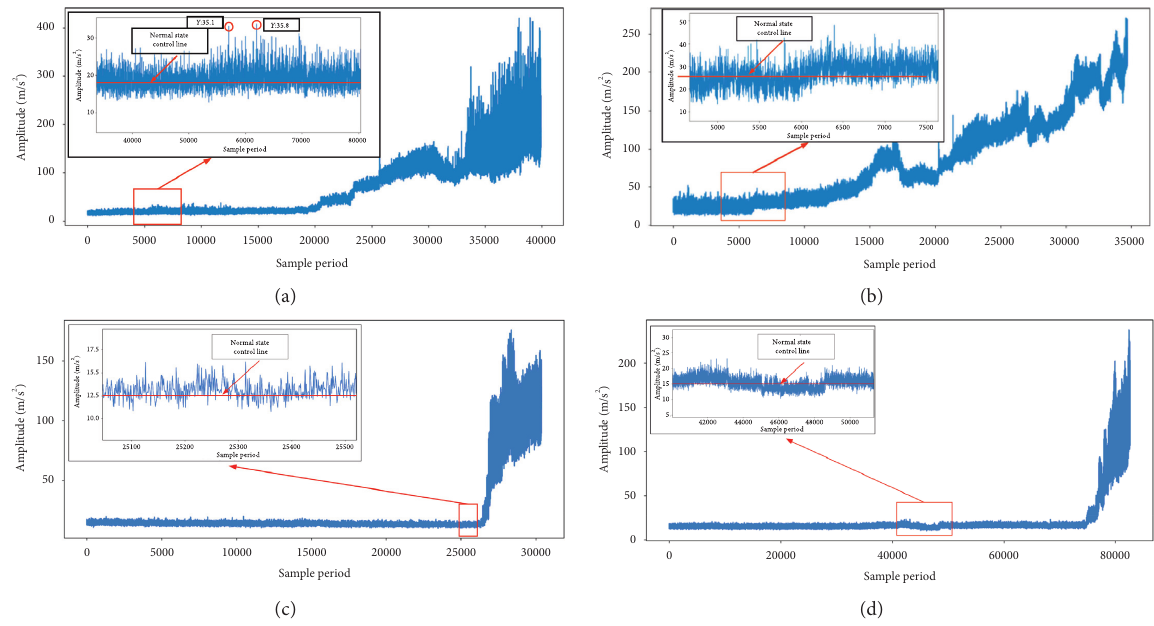
Figure 8: Description curve of the running state of rolling bearings. (a) Bearing2_3. (b) Bearing2_5. (c) Bearing3_3. (d) Bearing3_4.